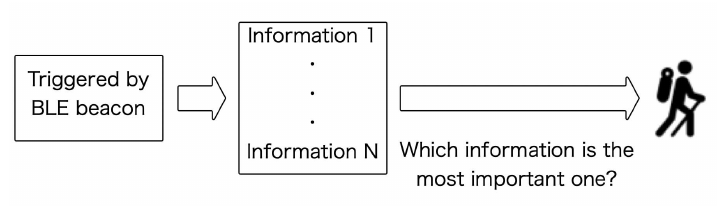
Figure 11. A model to provide